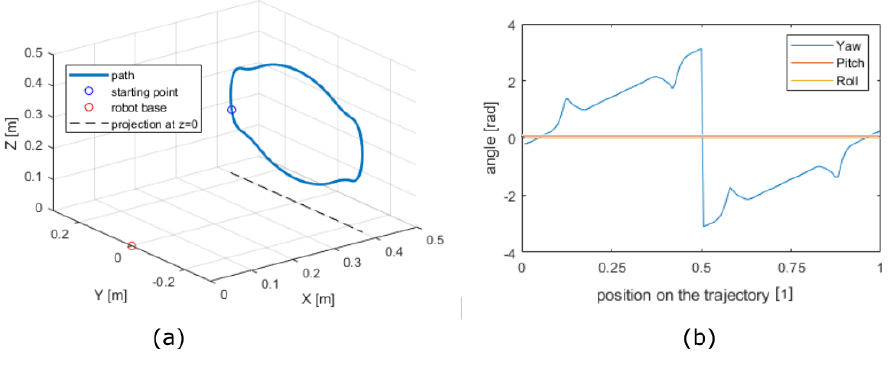
Figure 9. Task 2: ( a ) position; ( b ) orientation.